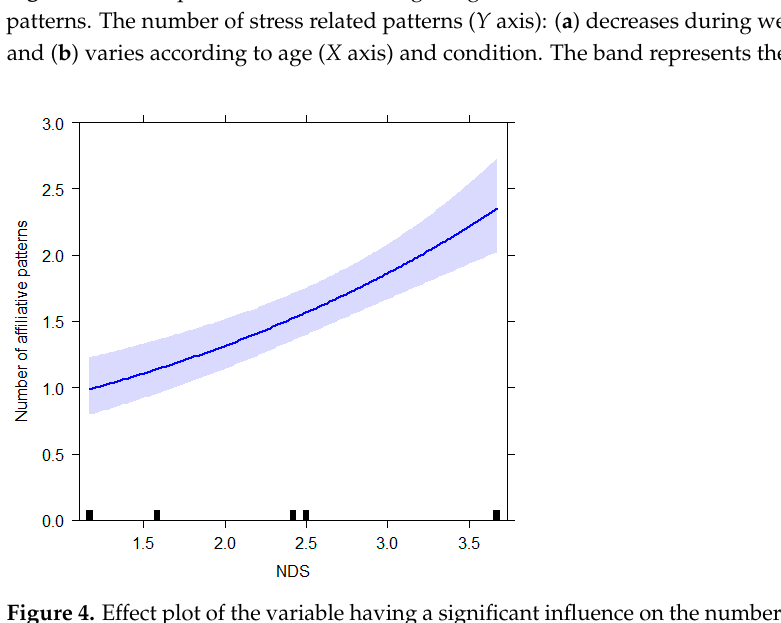
Figure 3. Effect plot of variables having a significant influence on the number of stress related pat ‐ terns. The number of stress related patterns (Y axis): ( a ) decreases during weekend days (X axis) and ( b ) varies according to age (X axis) and condition. The band represents the confidence interval.